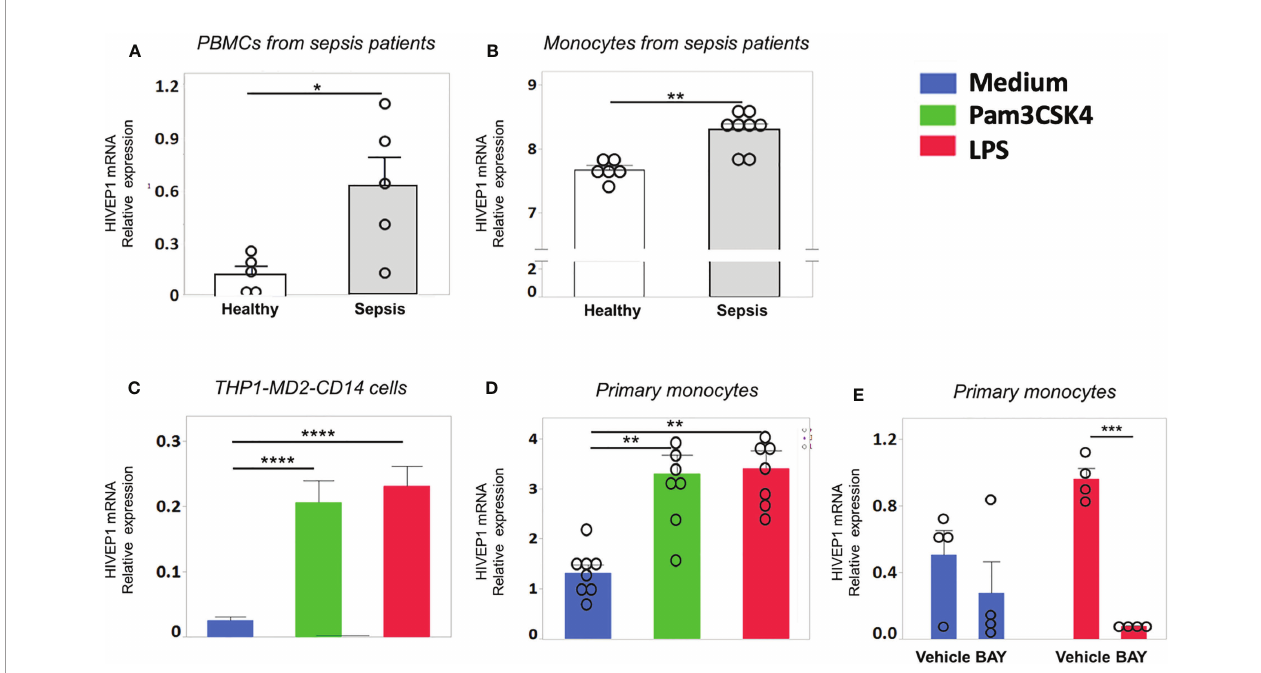
FIGURE 1 | HIVEP1 mRNA expression is increased in patients with sepsis and upon stimulation with bacterial agonists in vitro . HIVEP1 mRNA in PBMCs (A) and monocytes (B) from patients with sepsis (5 and 8 individual donors, respectively) upon admission to the intensive care unit and in healthy subjects (5 and 6 individual donors, respectively). The monocytes data was obtained from GEO database (GSE46955). (C) HIVEP1 mRNA in human monocytic wild type THP1- MD2-CD14 cells incubated with medium, PAM3CSK4 (1 µg/ml) or LPS (100 ng/mL) for 4 hours. (D) HIVEP1 mRNA in primary human monocytes incubated with medium (control), PAM3CSK4 (1 µg/ml) or LPS (100 ng/mL) for 4 hours. For (C) , three experiments with four replicates were conducted. For (D) , two experiments each with 4 independent donors (8 individual donors in total) were conducted. Pooled data from three (C) or two (D) independent experiments are displayed. (E) HIVEP1 mRNA in primary human monocytes (from 4 individual donors) incubated with medium or LPS (100 ng/mL) for 2 hours in the presence or absence of the NF k B inhibitorBAY11-7082 (or vehicle) added 30 minutes prior to LPS. HIVEP1 mRNA expression was normalizedto HPRT mRNA (A,C,D,E) . For (B) normalized gene expression values were used as provided in GSE46955. Data shows means ± SEM with individual data shown as dots. *P < 0.05, **P < 0.01, ***P < 0.001, ****P <